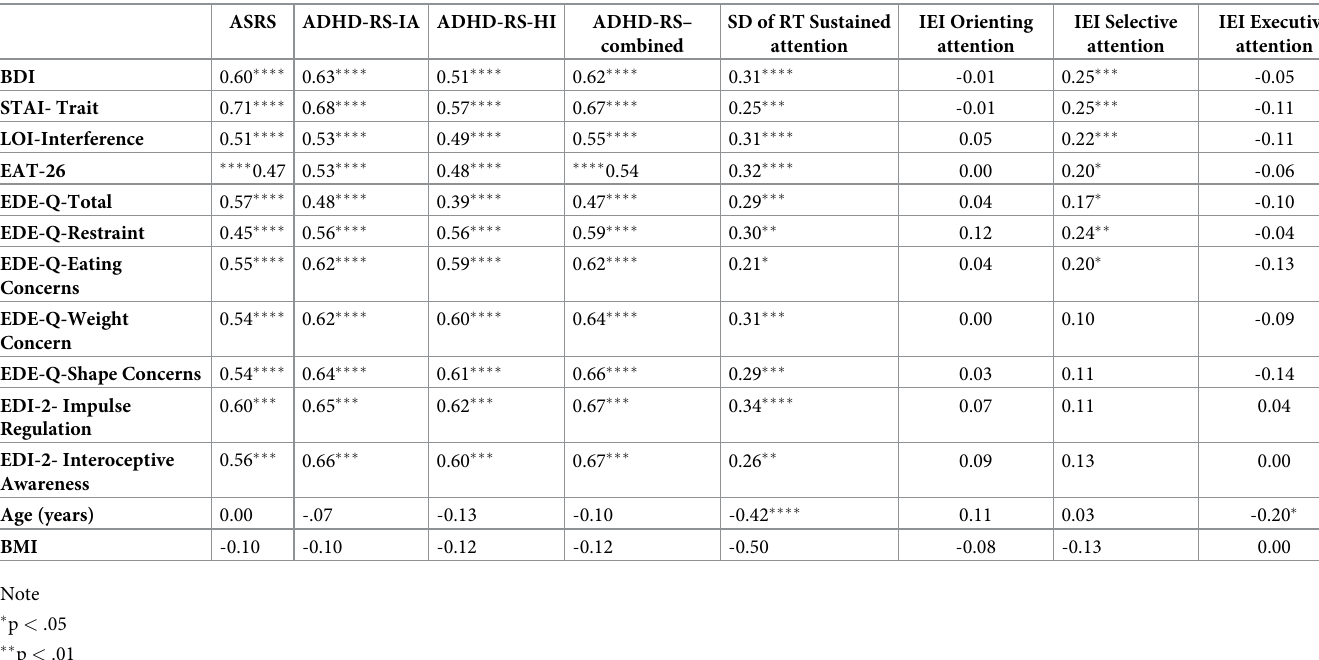
Table 3. Correlations among attention measures and ED symptoms, depression, anxiety, obsessionality, age and BMI. ASRS